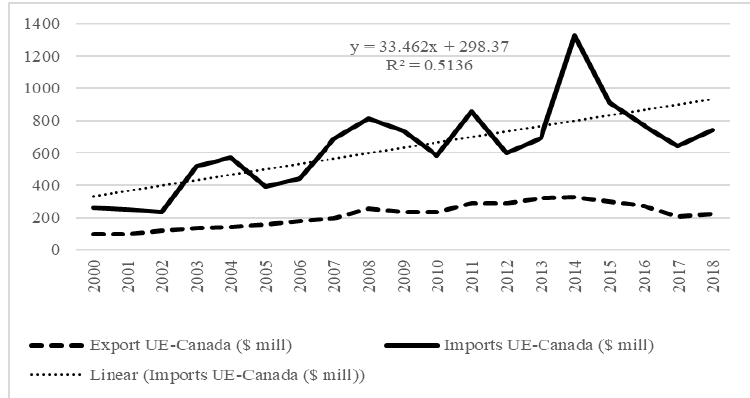
Figure 3. Evolution of bilateral trade in cereals between the EU and Canada. Source: Authors’ Figure3. EvolutionofbilateraltradeincerealsbetweentheEUandCanada. Source: Authors’elaboration. elaboration.